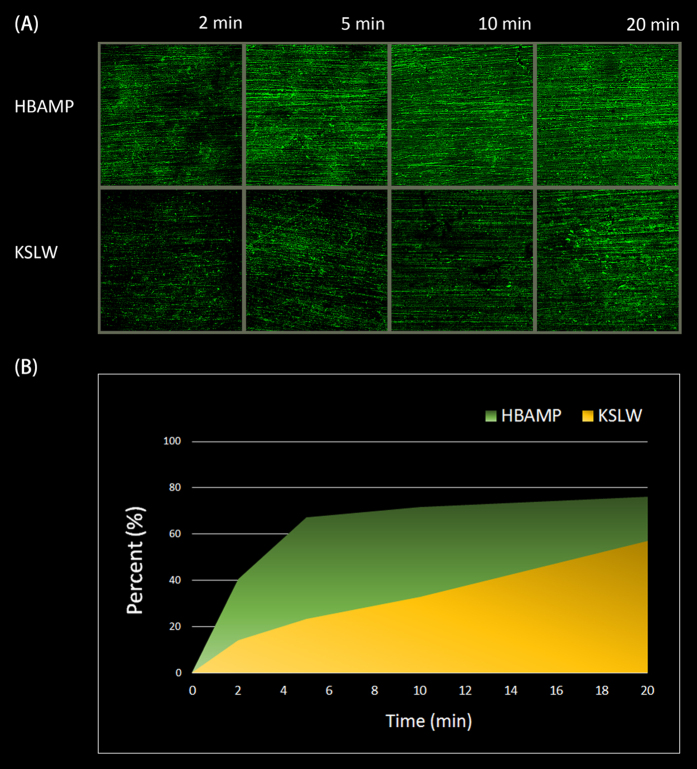
CLSM images of FITC-HBAMP and FITC-KSLW bound to HAp disk surface.(A) At the same molar concentration, the stronger fluorescent intensity on the surface pre-coated with HBAMP than the surface pre-coated with KSLW at the same time. (B) The relative amounts of fluorescent pixels at various time points.